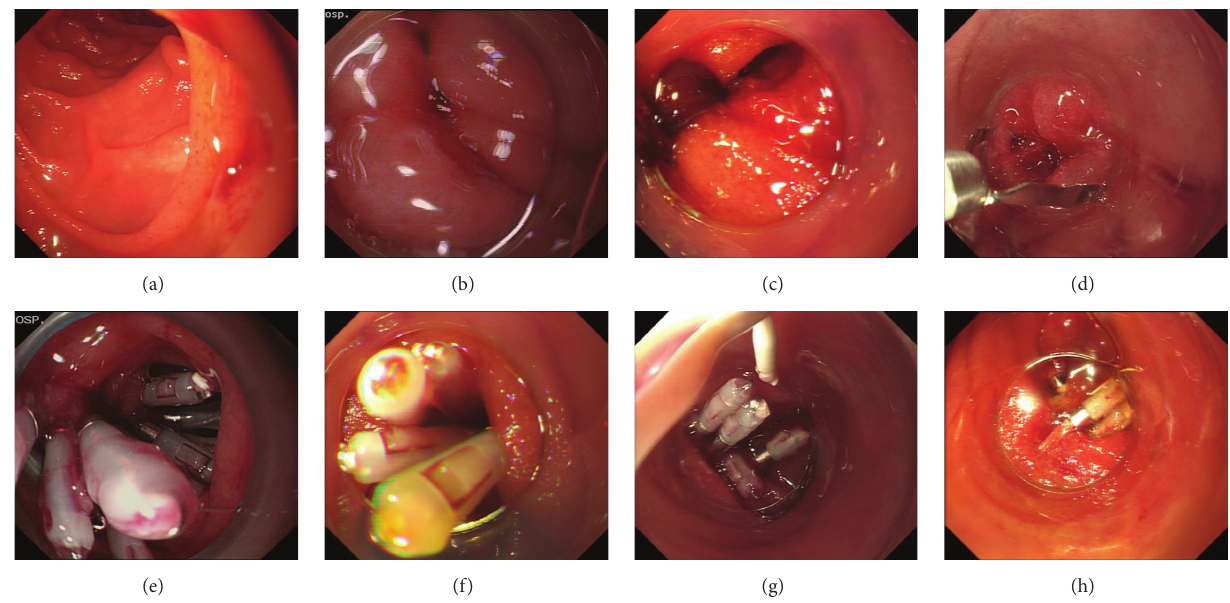
Figure 2: Typical endoscopic images were shown before (a–d) and after (e–h)